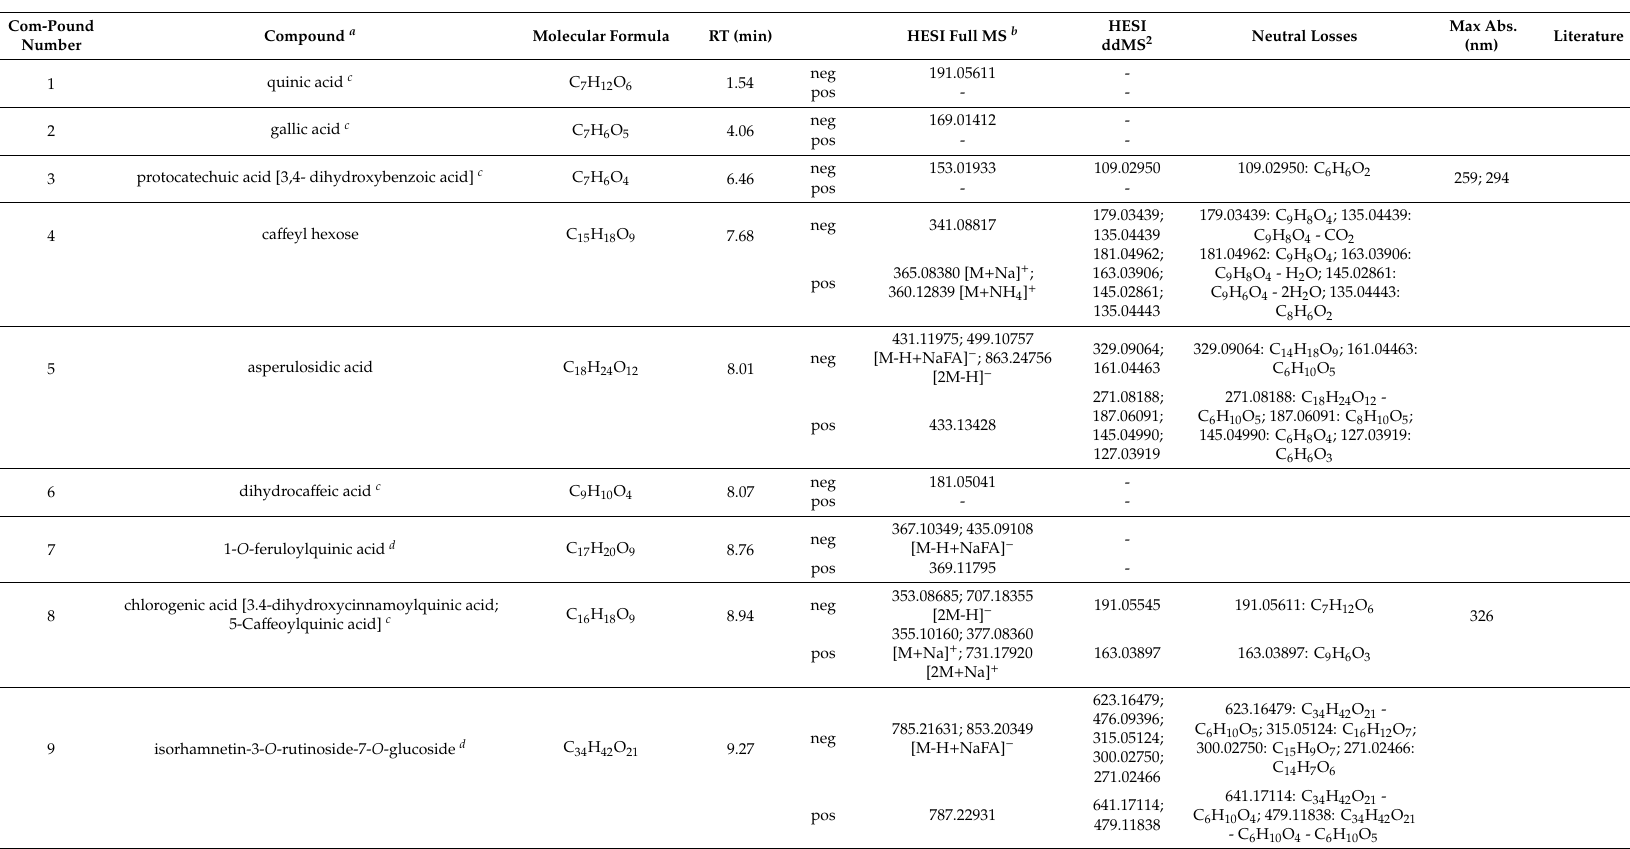
Table 1. Chromatographic and Spectrometric Data of the Tentatively Identified Compounds in H. hirsuta Detected with a Generic LC-PDA-amMS Method for Moderately Polar